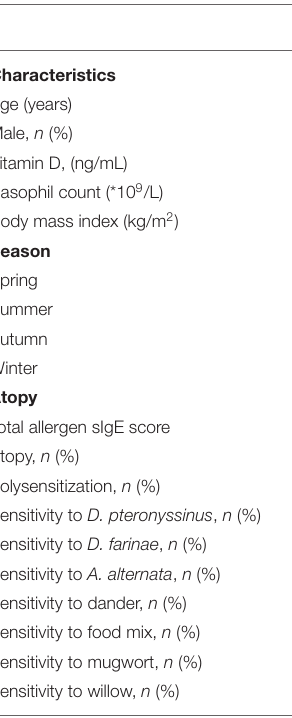
TABLE 1 | Basic characteristics of the study